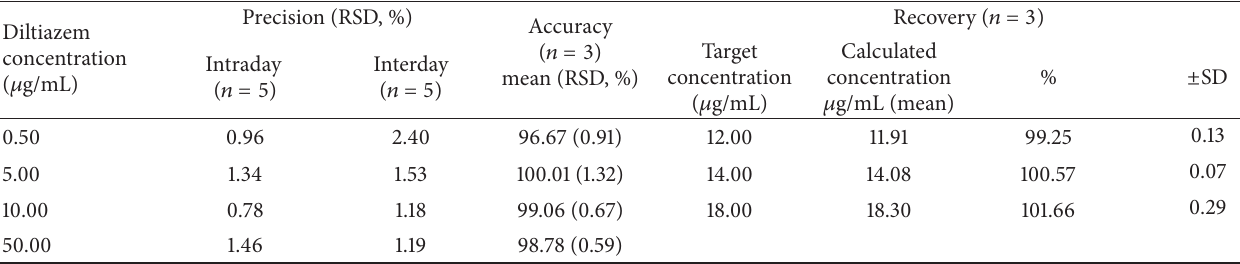
Table 2: Precision, accuracy, and recovery data for the proposed method.